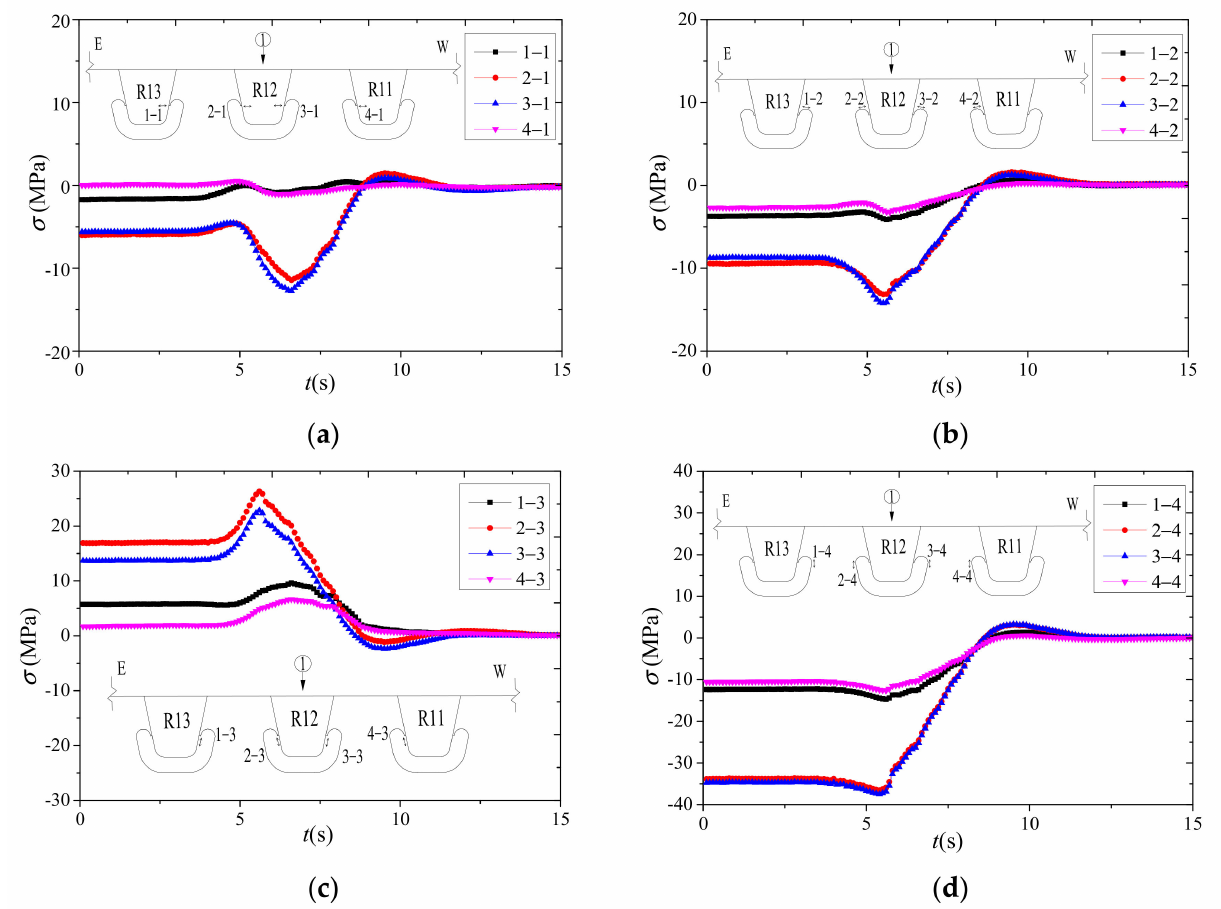
Figure 7. Stress records under LC1 loading cases. ( a ) RF-R; ( b ) RF-F; ( c ) RF-W; ( d ) Cutout.